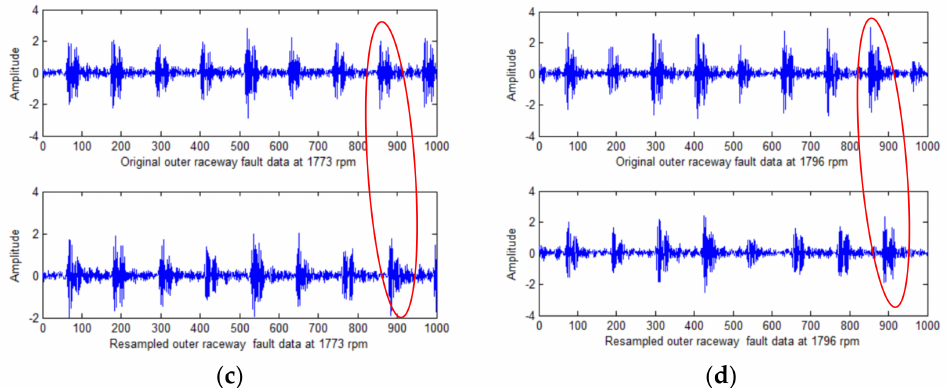
Figure 7. The experimental results of order tracking: ( a ) resampling results at 1725 speed; ( b ) resam- pling results at 1750 speed; ( c ) resampling results at 1773 speed; ( d ) resampling results at 1796 speed.